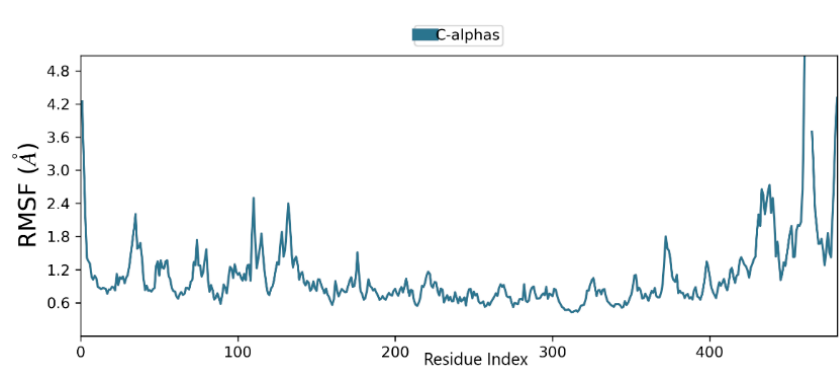
Figure 9. ( A ) MDSs trajectory output revealing the root-mean-square deviation (RMSD) plot of CID- 472632 bound to MNV RdRp; ( B ) Binding interaction of CID- 472632 -MNV RdRp after MDSs; ( C ) Ligplot representing interaction of CID- 472632 with different residues of MNV RdRp throughout the simulation trajectory ( D ) Graphical depiction of root-mean-square fluctuation (RMSF) of CID- 472632 with different residues of MNV RdRp.